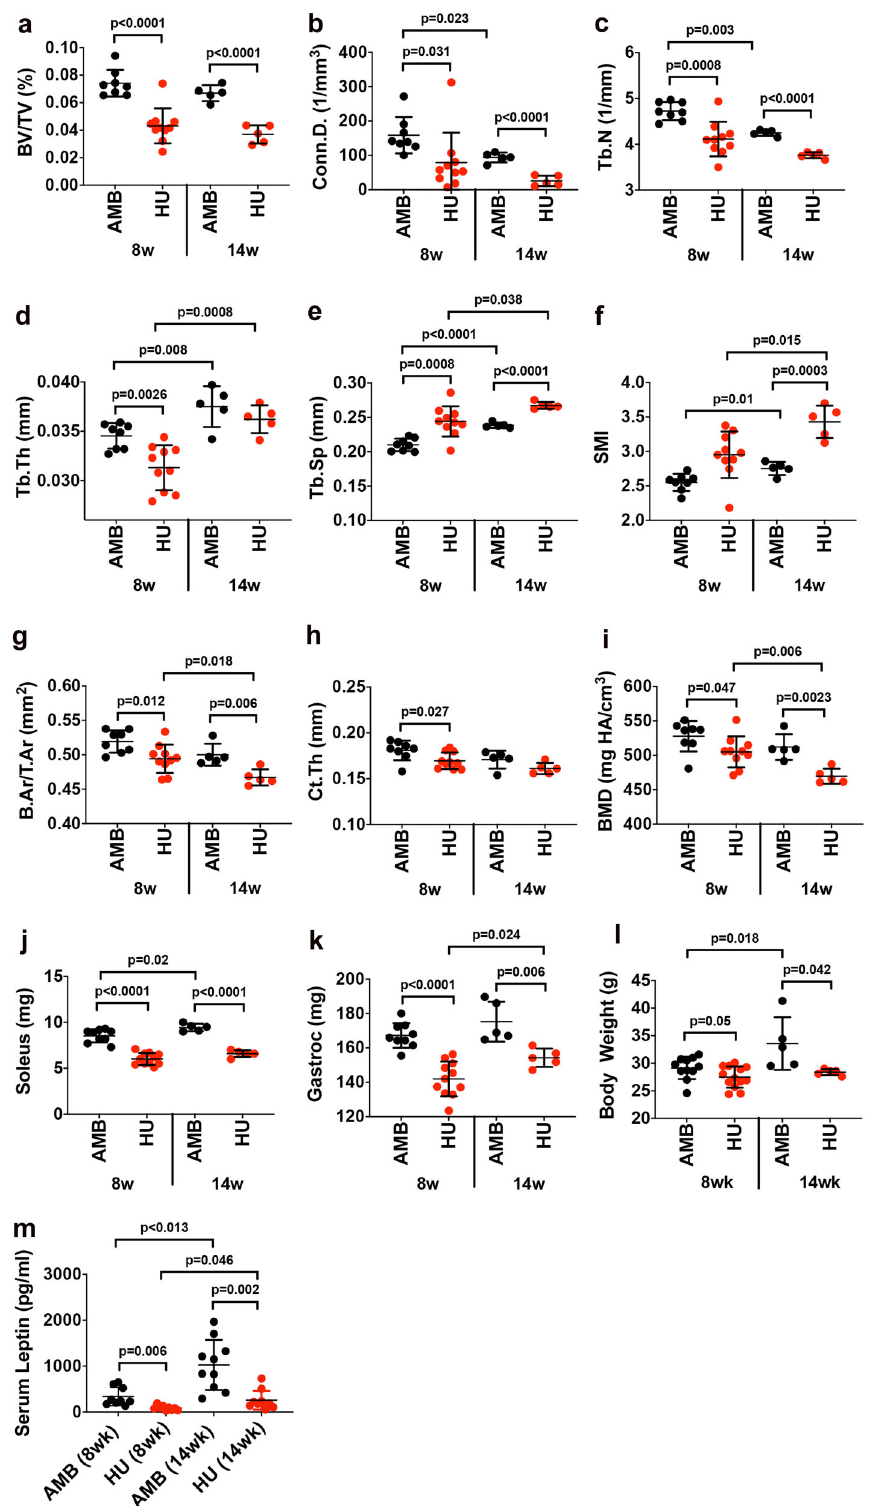
Fig. 4 Prolonged HU induces progressive bone loss. a – f Quanti fi cation of BV/TV ( a ), Conn.D. ( b ), Tb.N. ( c ), Tb.Th. ( d ), Tb.Sp. ( e ) and SMI ( f ) by micro-CT analysis of the proximal tibiae from 8 and 14wk HU mice and their respective AMB controls ( n = 5 – 10 mice/group). g – i Quanti fi cation of B.Ar/T.Ar ( g ), Ct.Th. ( h ), and BMD ( i ) by micro-CT analysis of the distal tibiae from mice in a ( n = 5 – 10 mice/group). j – m Endpoint measures of soleus ( j ) and gastrocnemius ( k ) mass, body weight ( l ), and serum leptin levels ( m ) from 8 and 14wk HU mice and their AMB controls ( n = 5 – 10 mice/group). Data are mean ± SD. P -values are by one-way ANOVA and Tukey ’ s post hoc